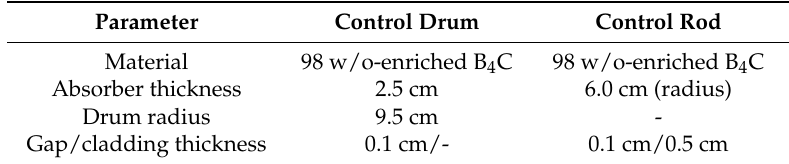
Table 3. Design parameters of control drum and the central control rod.